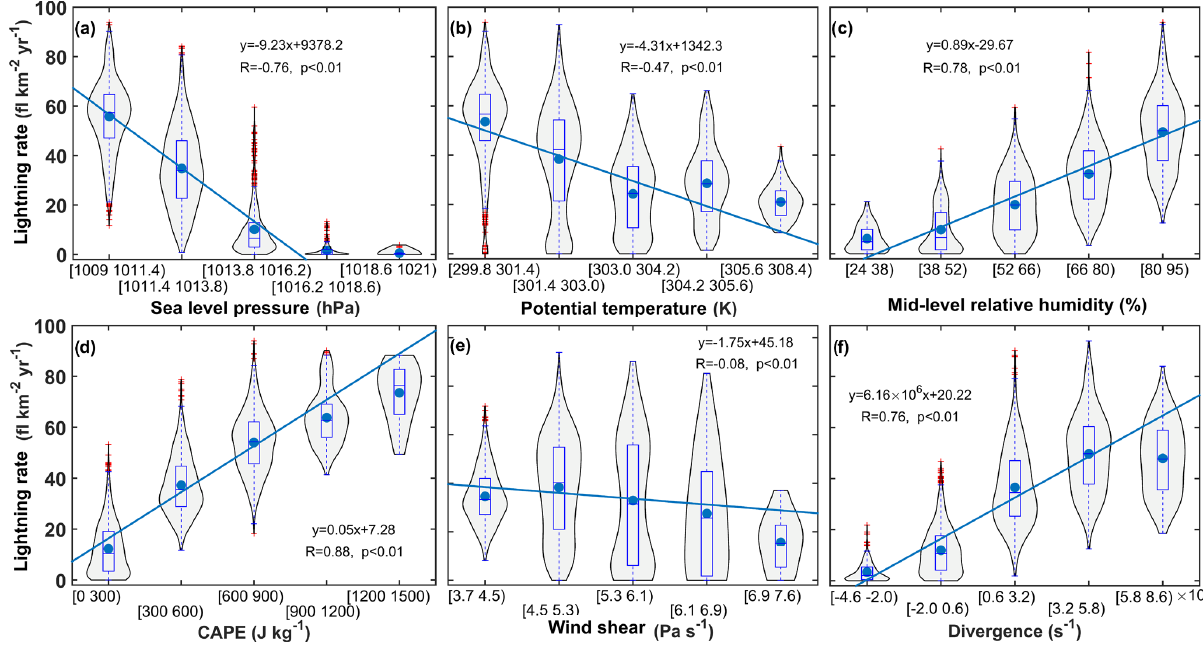
Figure 6. Same as in Fig. 5, but for the smoke-dominant region. Mean values are represented by blue dots, and linear regression lines are shown in blue.